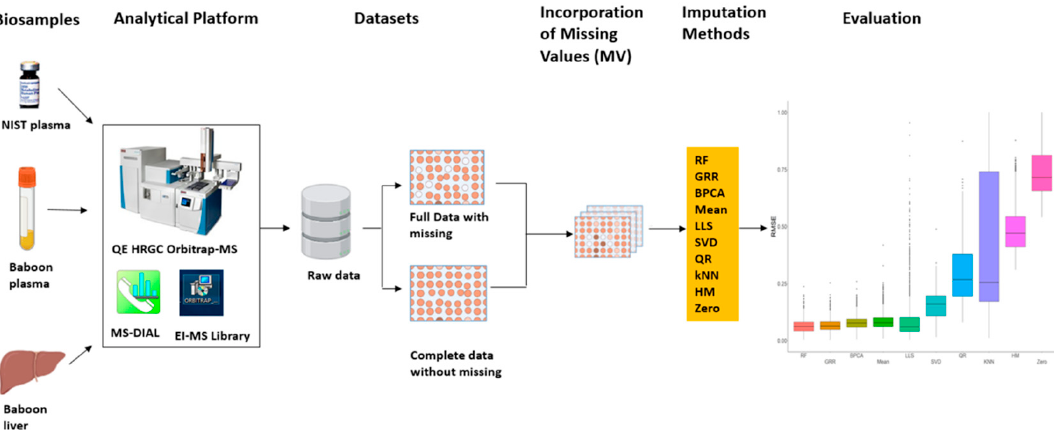
Figure 1. Metabolomics imputation study workflow. Diagram detailing metabolomics sample analysis, evaluation of imputation methods in technical replicate dataset (NIST plasma), and further validation in real baboon plasma and liver metabolomics datasets.